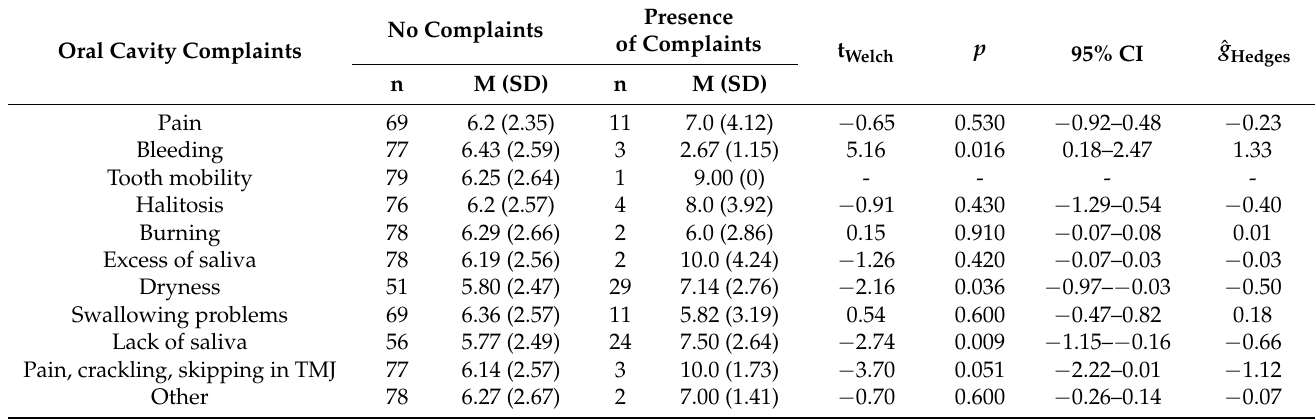
Table 6. Relationship between oral cavity complaints and the number of medications.